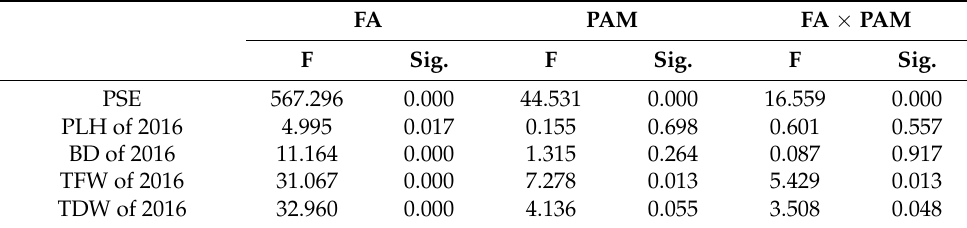
Table 5. Two-way ANOVA of the effects of CSL on the growth characteristics of Artemisia ordosica in 2016. FA PAM FA × PAM F Sig. F Sig. F